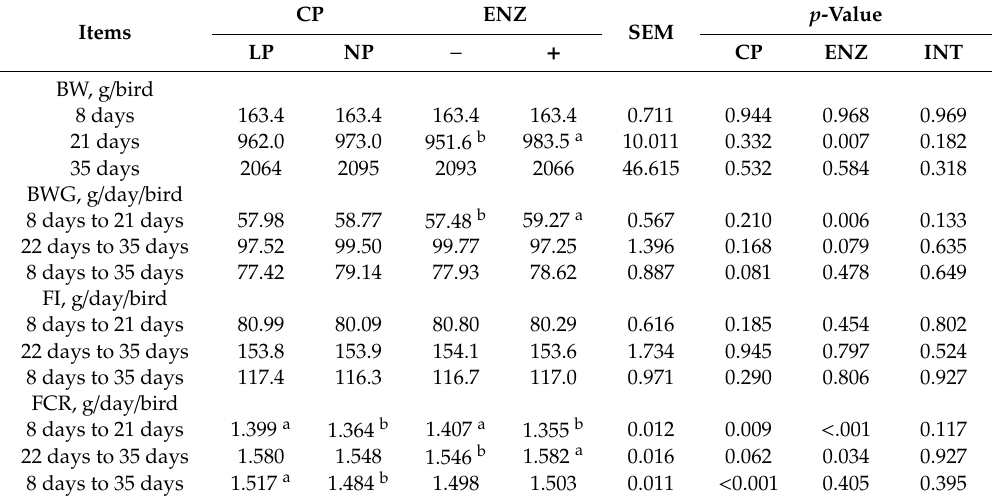
Table 2. E ff ect of low-protein diet and exogenous protease on growth performance in broiler chickens.